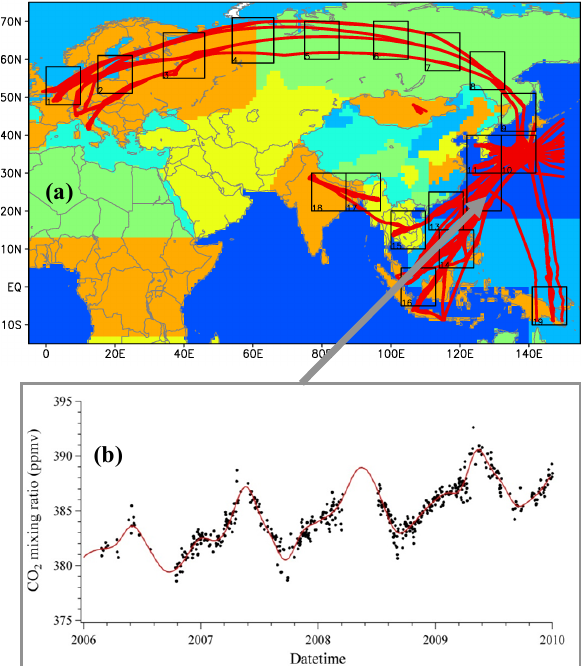
Figure 1. A map of CONTRAIL measurements; (a) the CONTRAIL measurement locations (red dots), black rectangles represent the area partitions of the measurements of level flights, shaded represent different inversion regions over Eurasia; (b) Time series of the measurements over East China Sea, red line indicates a curve fitted to the daily CO 2 .